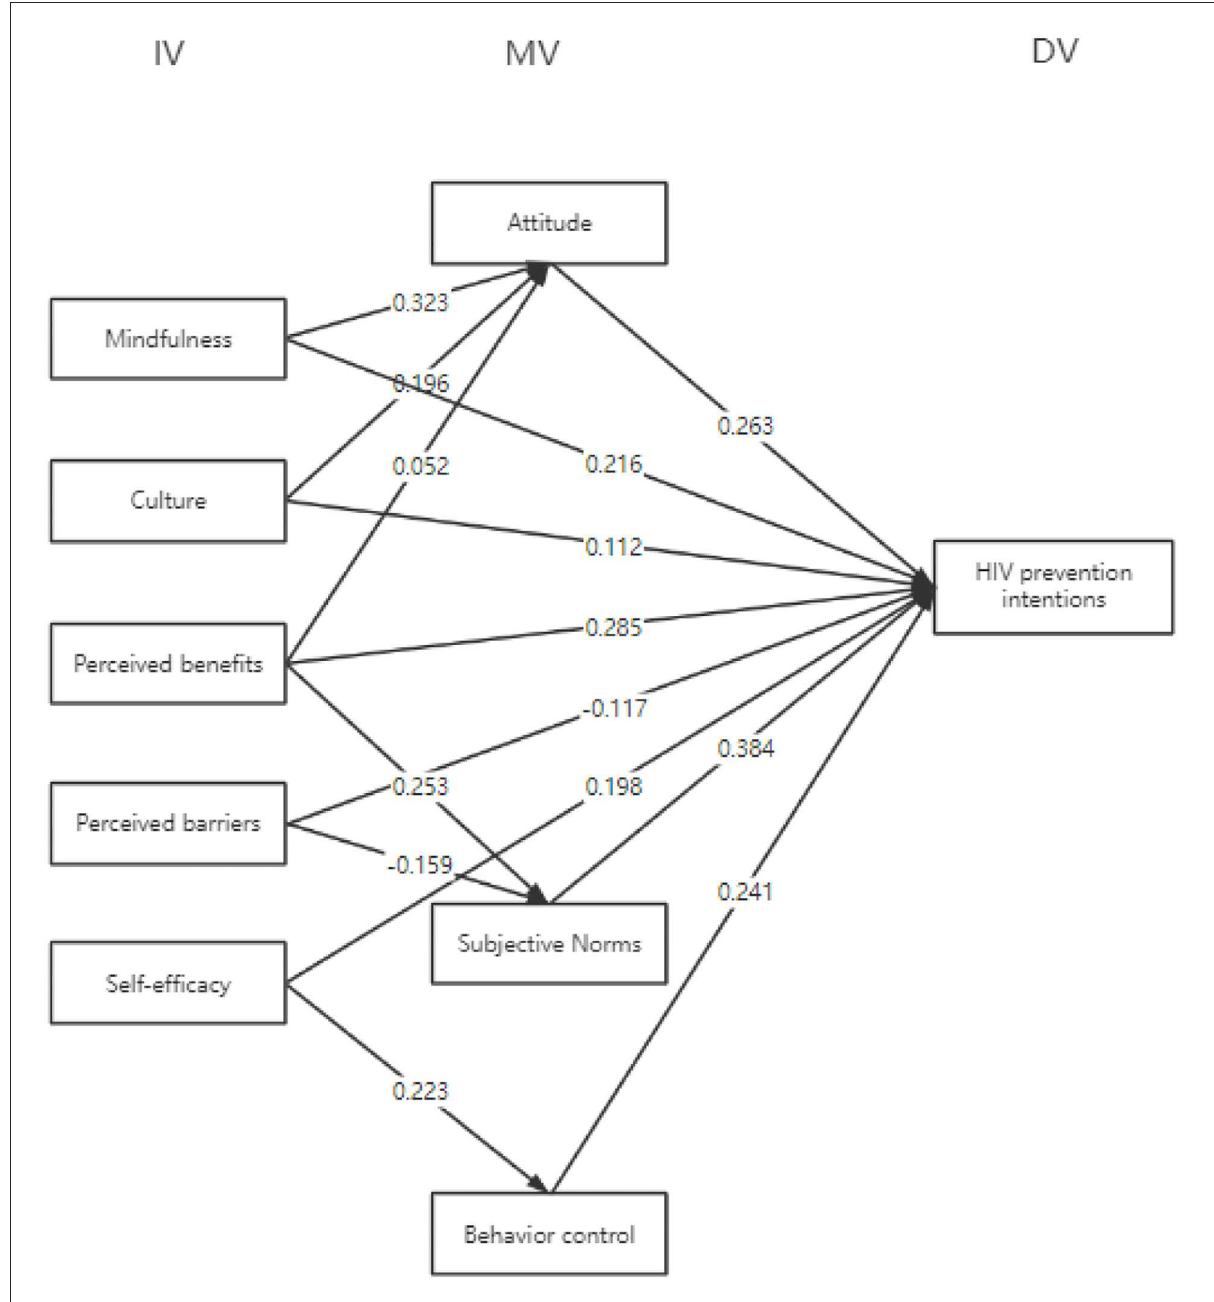
FIGURE5 SEM model fitting for prediction of HIV prevention intention in users.